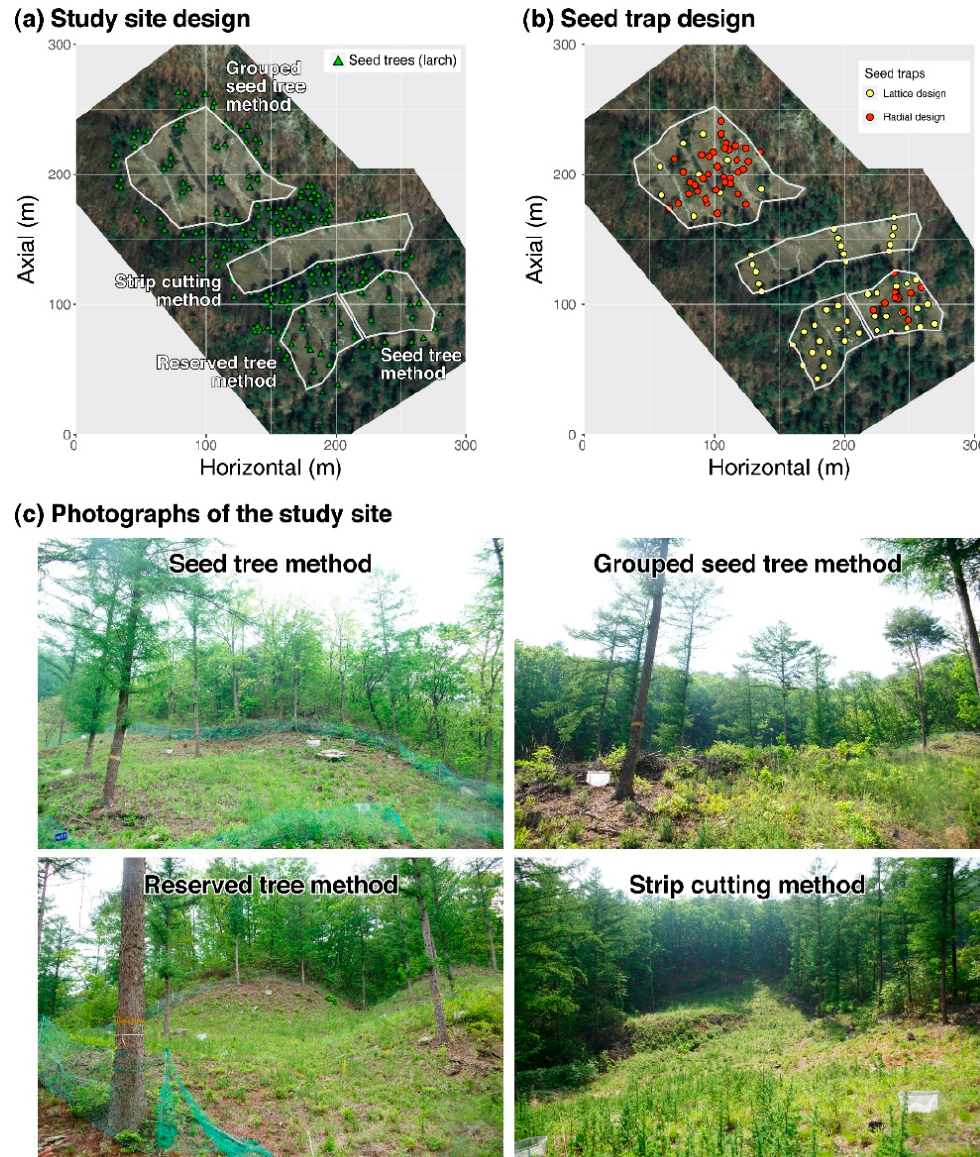
Figure A1. Placement of natural regeneration patches and seed trees ( a ), placement of seed traps ( b ), and photographs of the study site taken in May 2020 ( c ).